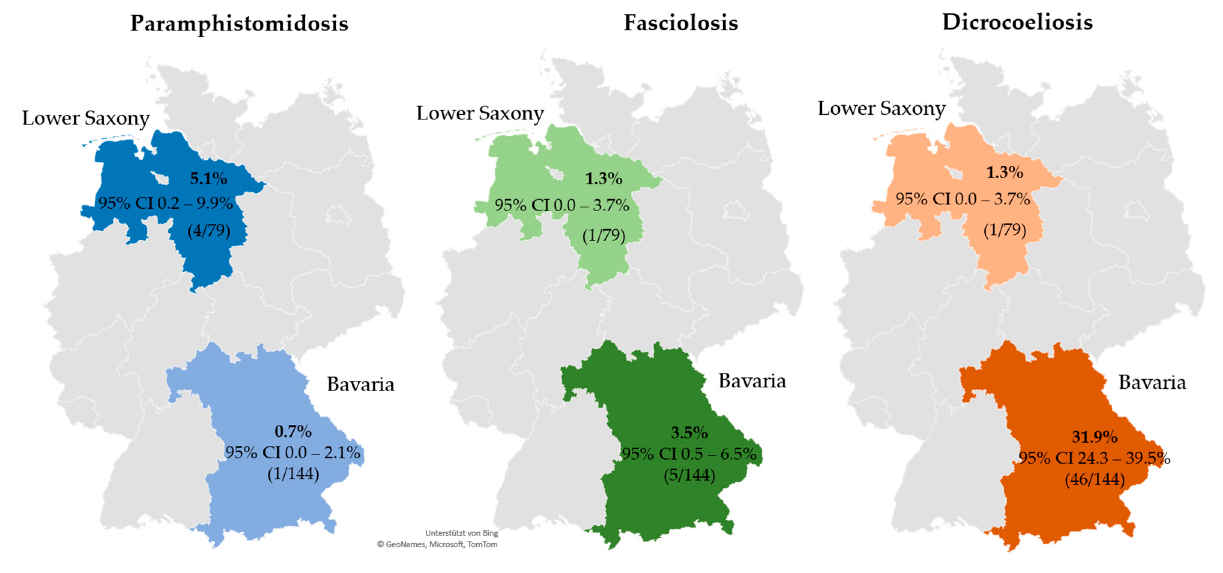
Figure 1. Prevalence of patent paramphistomidosis, fasciolosis and dicrocoeliosis, including 95% CI for sheep farms in Bavaria and Lower Saxony (co-infections included). Abbreviations: CI, confidence interval. Table 6. Results of simple logistic regressions for the prevalence of patent rumen fluke, F. hepatica and D. dendriticum infections on sheep and goat farms by federal